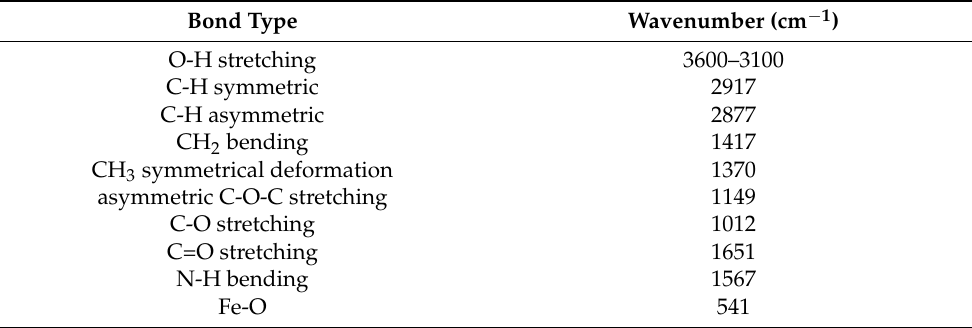
Figure 2. FT-IR spectra of the CS/D ( a ) and CS/D/G ( b ) hydrogels. Table 2. Bonds assigned to the absorption bands registered within the FT-IR spectra.